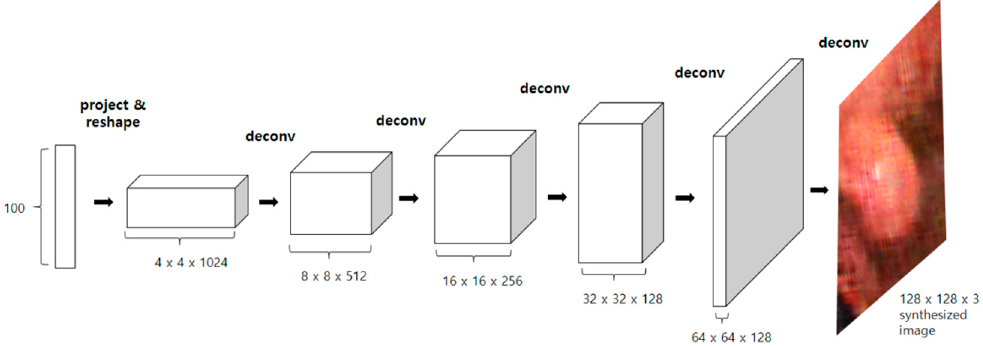
Figure 6. Generator architecture of the deep convolutional generative adversarial network (DCGAN).